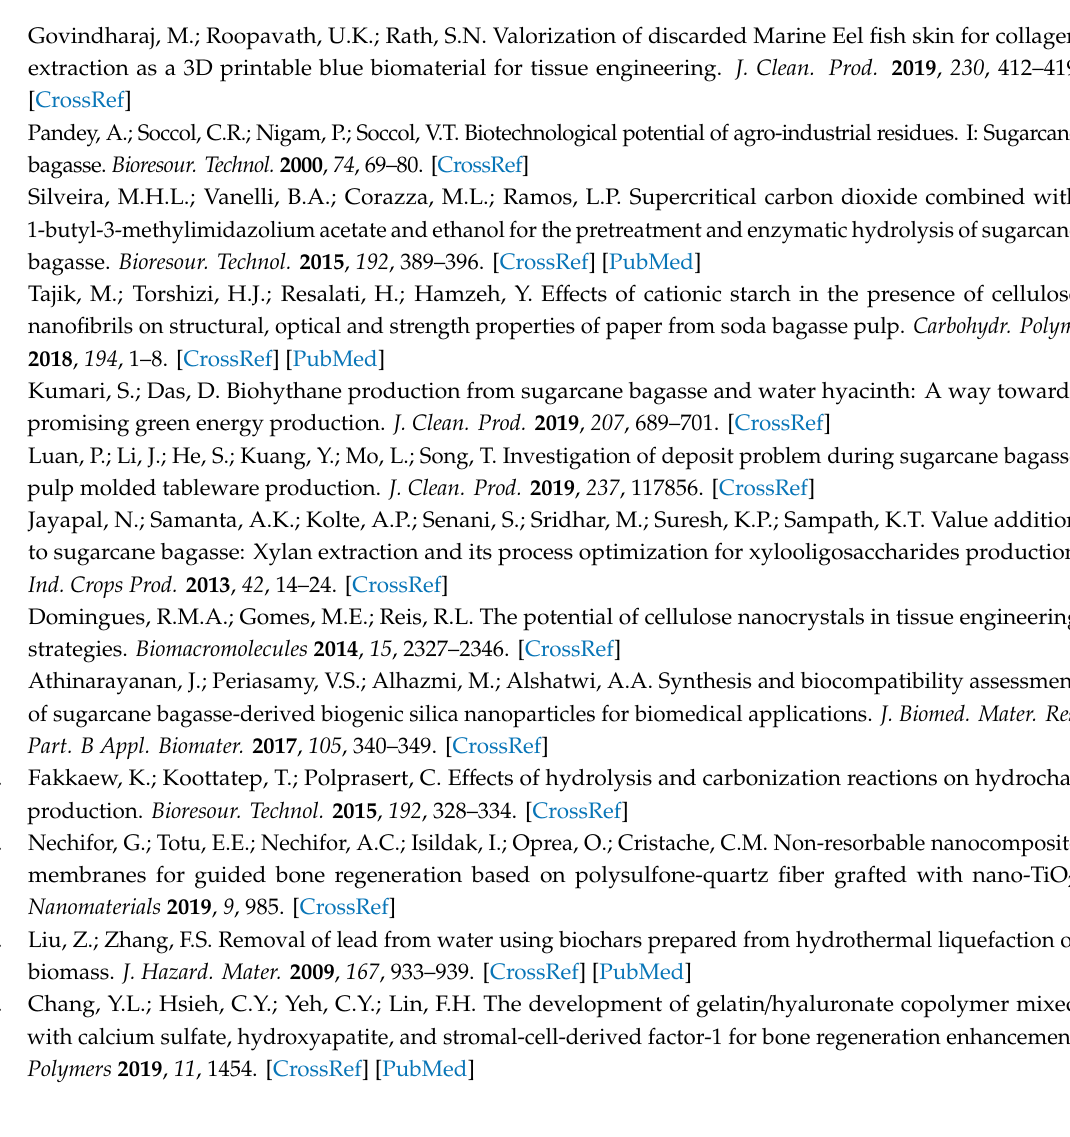
Table S1: Element, binding energies, and atomic concentrations (%) from XPS analysis of SCBH@Fe 3 O 4 ., Table S2: The detailed thermal characteristics of SCB-H and SCB-H@ Fe 3 O 4